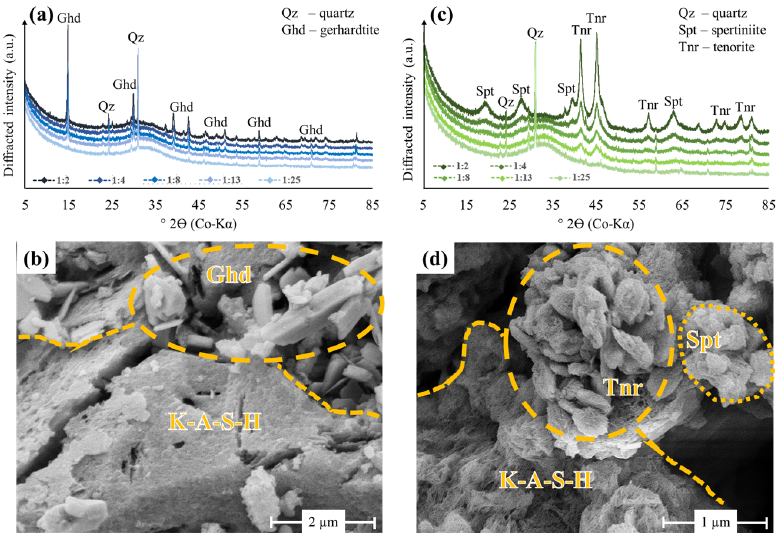
Figure 3. Mineralogy and microstructure of Cu-GPs obtained from the Cu 2+ immobilization experiments of the Cu:GP series (left panel) and Cu:GP pH series (right panel). ( a , c ) XRD patterns of all precipitates; ( b , d ) SE images of precipitates from experiments Cu:GP-1:2 and Cu:GP pH -1:2, respectively. The copper nitrate hydroxide gerhardtite (Cu 2 (NO 3 )(OH) 3 ) precipitated in